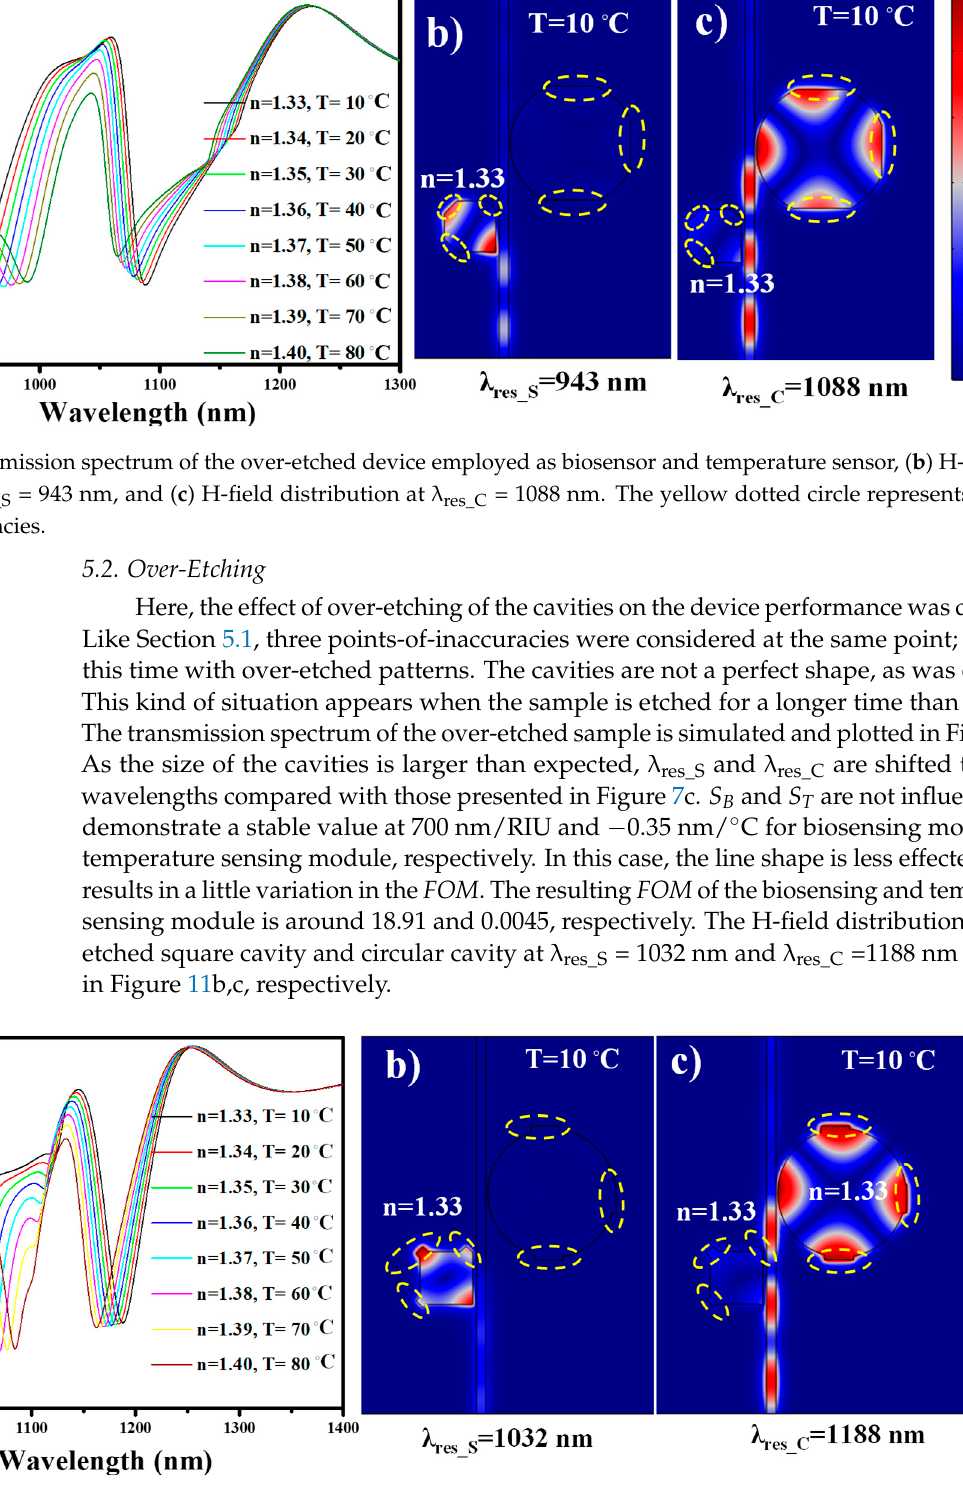
Figure 11. ( a ) Transmission spectrum of the under-etched device employed as biosensor and temperature sensor, ( b ) H-field distribution at λ res_S = 1032 nm, and ( c ) H-field distribution at λ res_C = 1188 nm. The yellow dotted circle represents the fabrication